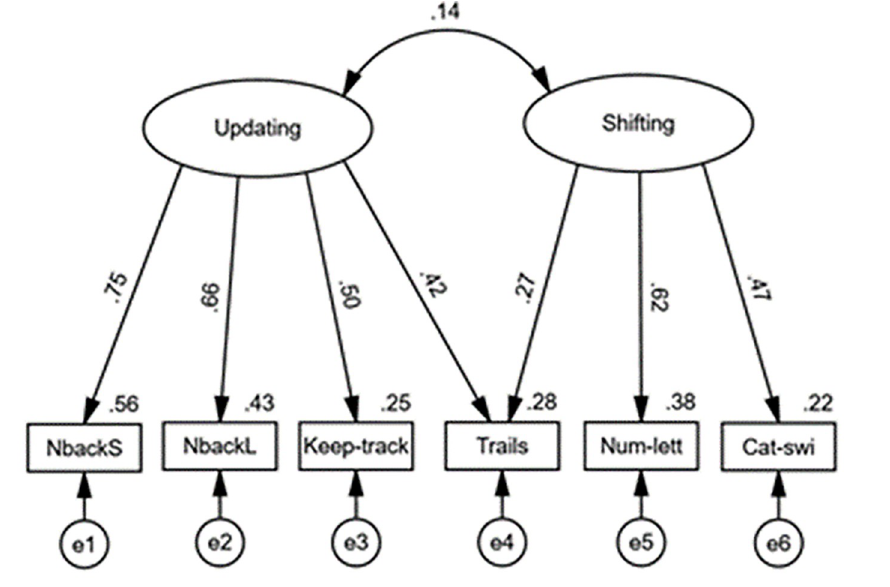
Fig 2. Confirmatory factor analysis of EF-subcomponent latent variables in correlated two-factor model. Note. Straight lines with single arrows are regression paths. The observed variables at the bottom represent EF-task scores. Numbers on top-right of observed variables represent proportion of variance accounted for in each variable. Error terms associated with each observed variable are indicated by e1-6. Factor loadings and correlations are fully